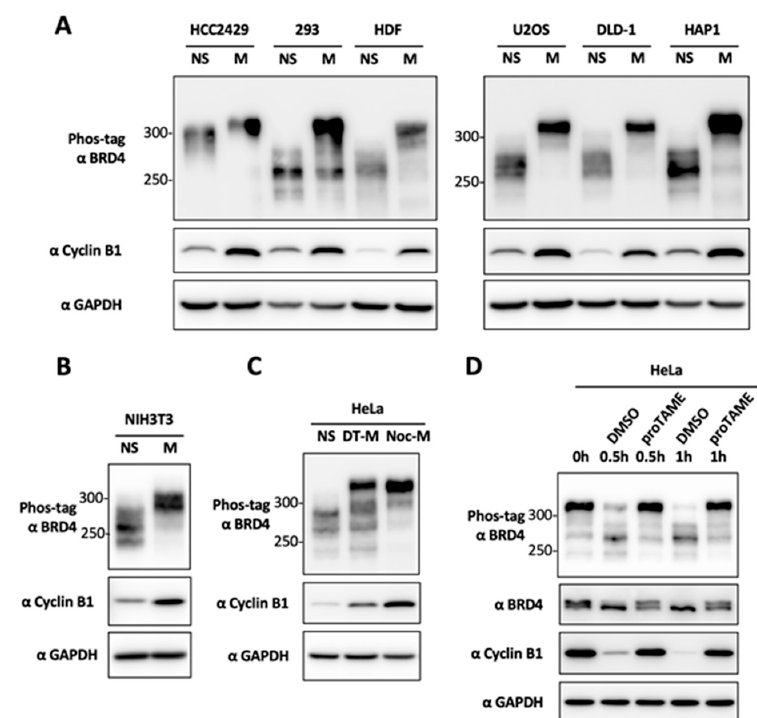
Figure 1. BRD4 is hyperphosphorylated during mitosis. ( A ) HCC2429, HEK293, HDF, U2OS, DLD-1 and HAP1 cells were not synchronized (NS) or synchronized in mitosis (M) using nocodazole. Whole-cell lysates were resolved in Phos-tag or SDS / PAGE gels and immunoblotted using the indicated antibodies. ( B ) Mouse NIH3T3 cells were not synchronized (NS) or synchronized in mitosis (M) using nocodazole and analyzed as in ( A ). ( C ) HeLa cells were not synchronized (NS) or synchronized in mitosis (M) using nocodazole (Noc-M). Mitotic HeLa cells were also collected by shake-o ff at ten hours after releasing from double thymidine block (DT-M). Whole-cell lysates were analyzed as in ( A ). ( D ) Mitotic HeLa cells collected using mitotic shake-o ff were treated with DMSO or 12 µ M proTAME and harvested at the indicated time points. Whole-cell lysates were analyzed as in ( A ).